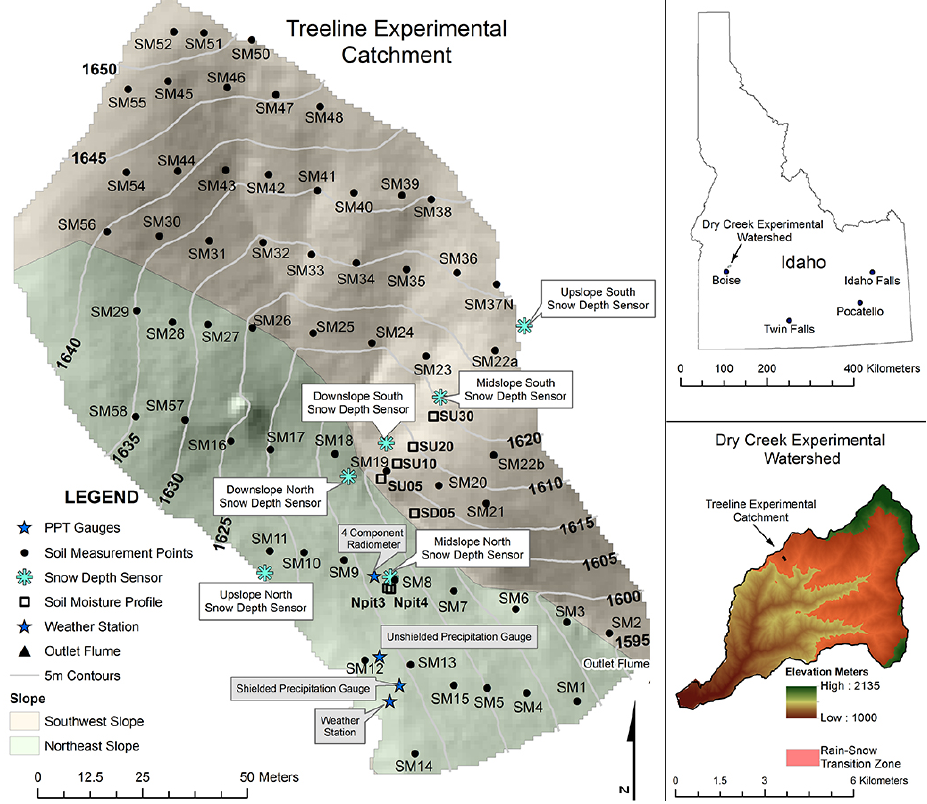
Figure 1. Location map of the Treeline experimental catchment in the Dry Creek experimental watershed and the location of instruments and measurement points.